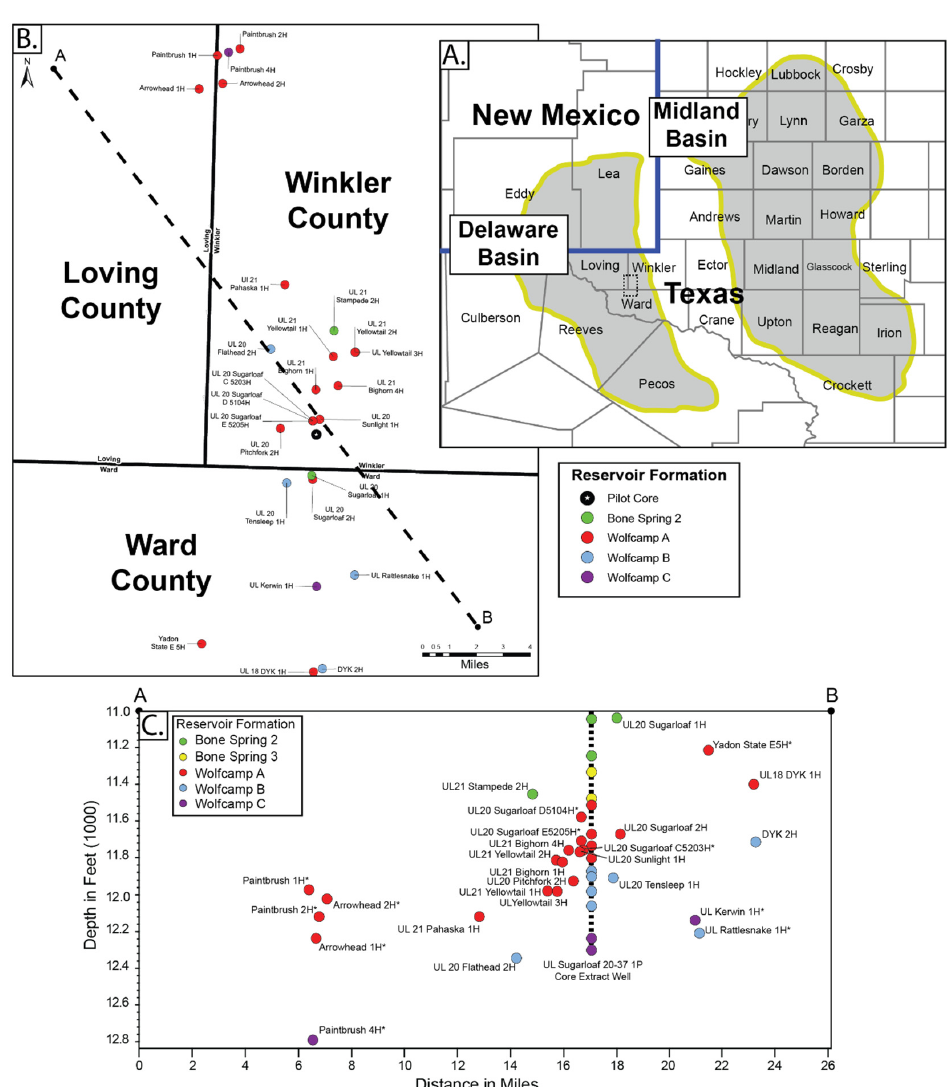
Figure 4. ( A ). Location Map of the sub ‐ basins of the Permian Basin (Delaware and Midland) in Texas and New Mexico. ( B ). Location Map of the wells discussed in the Delaware case study in this paper, located in Winkler, Ward and Loving Counties of Texas. The samples are color coded based upon their target landing formation. The geographic location of the cross ‐ section ( C ) is shown ( A , B ). ( C ). Cross ‐ section view of the wells analyzed in this study, color coded based upon landing formation. The well names marked with an * were added after the 1st round of sampling.